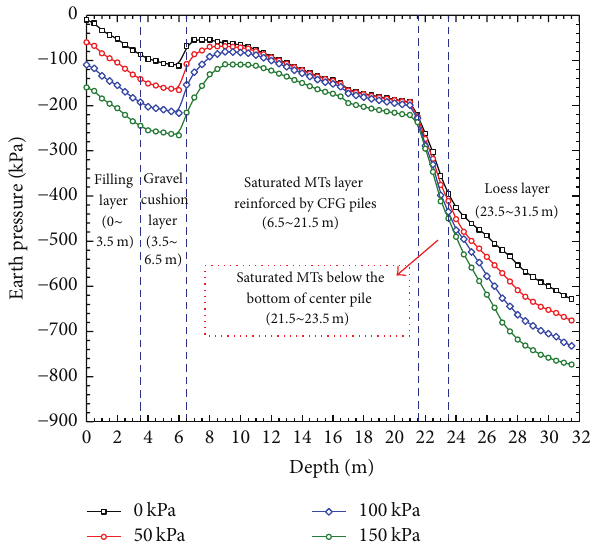
Figure 14: Distribution of the earth pressure with depth.